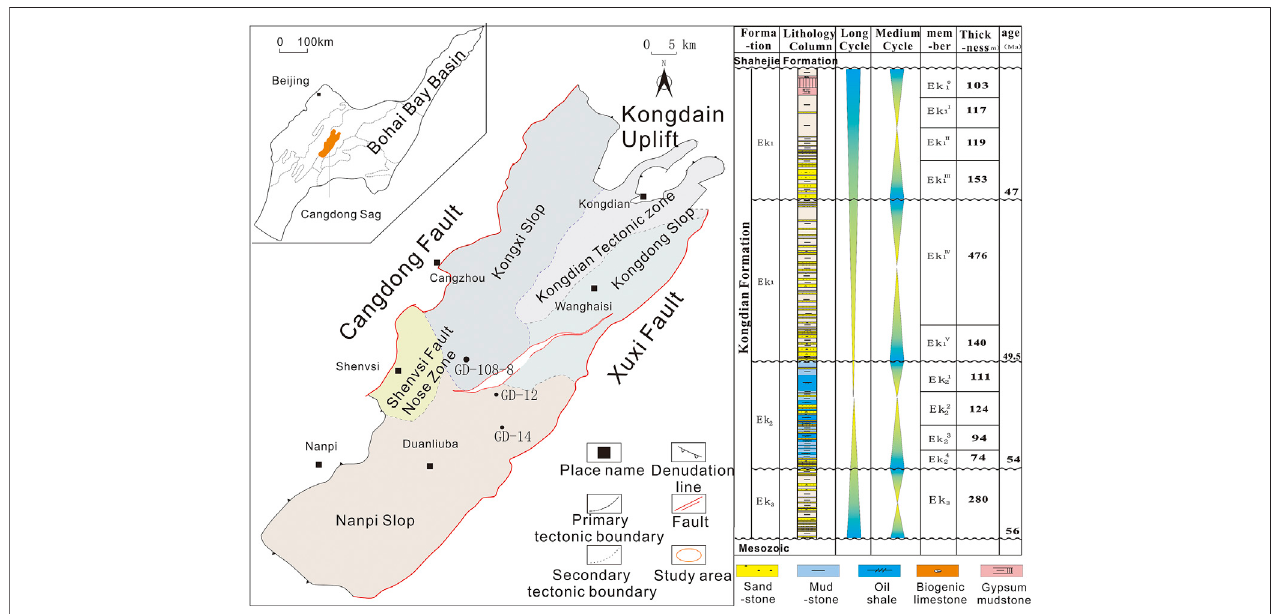
FIGURE 1 | Geological map and general stratigraphy of the Member 2 of Kongdian Formation in Cangdong sag, Bohai Bay Basin, China.